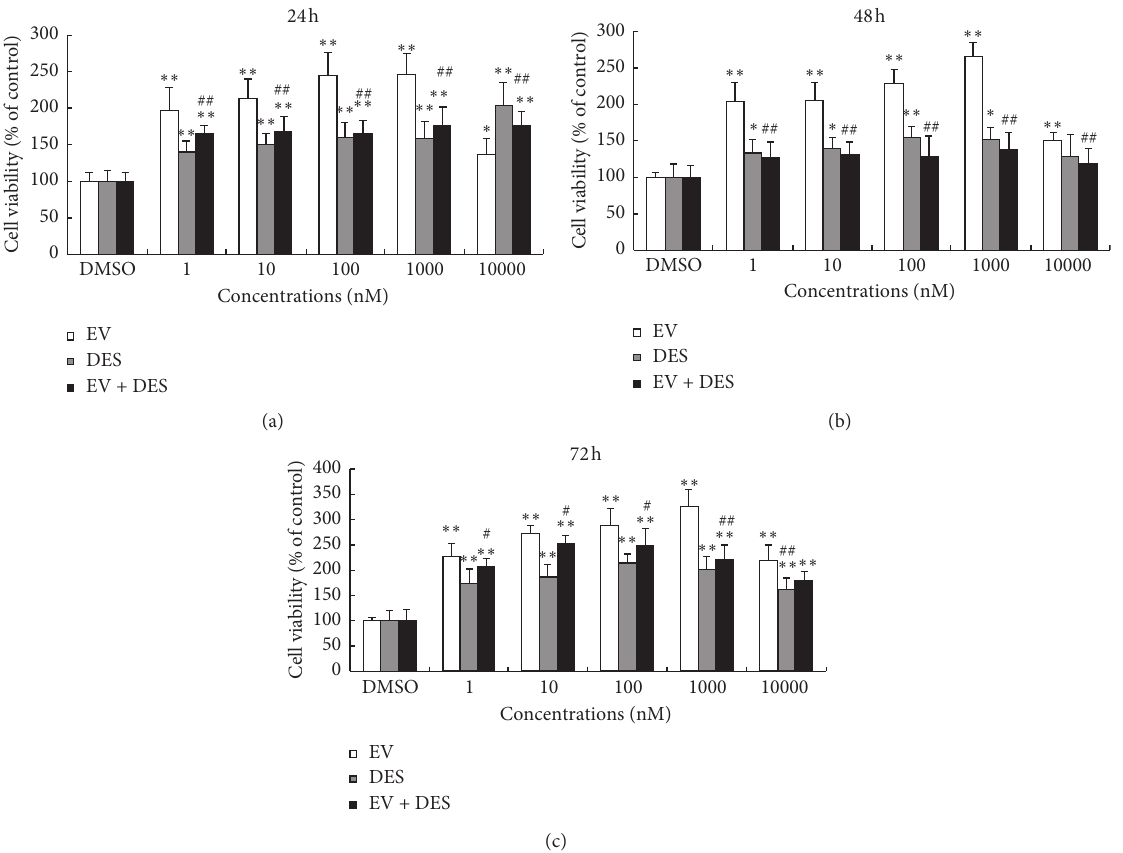
Figure 2: The binary joint effect of EV and DES on cell viability of MCF-7 cells. Exposure time: (a) 24h; (b) 48h; (c) 72h. Data points represent mean ± SD of three independent experiments. ∗ p < 0 . 05, ∗∗ p < 0 . 01 compared with DMSO; # p < 0 . 05, ## p < 0 . 01, compared with EV